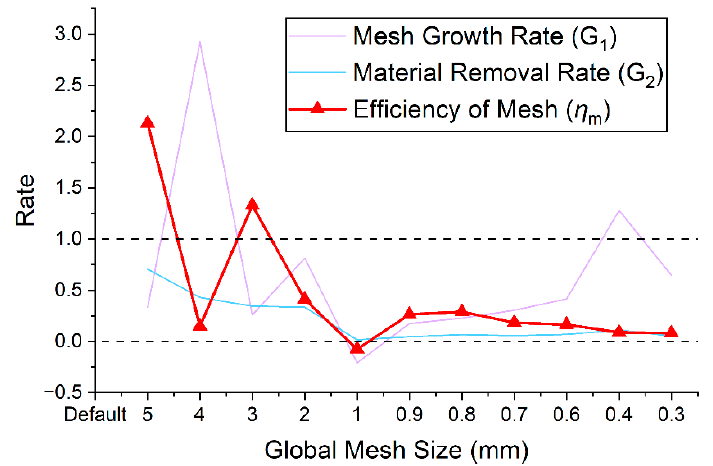
Figure 20. Utilization efficiency of mesh